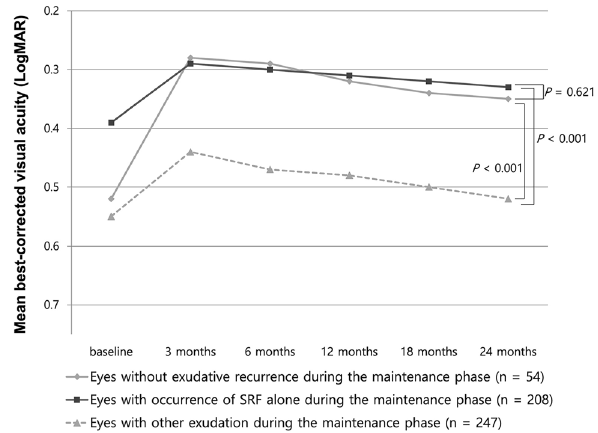
Figure 1. Changes in the mean best-corrected visual acuity (BCVA) expressed as the logarithm of the minimal angle of resolution during the 24-month follow-up, where anti-vascular endothelial growth factor treatment for neovascular age-related macular degeneration (AMD) was employed. At 24 months, the BCVA of eyes with only subretinal fluid (SRF) during the maintenance phase was comparable to that of eyes without exudative recurrence ( P = 0.621) and significantly better than that of eyes with exudation except for cases of SRF alone during the maintenance phase (Bonferroni correction after one-way analysis of variance, P < 0.001).